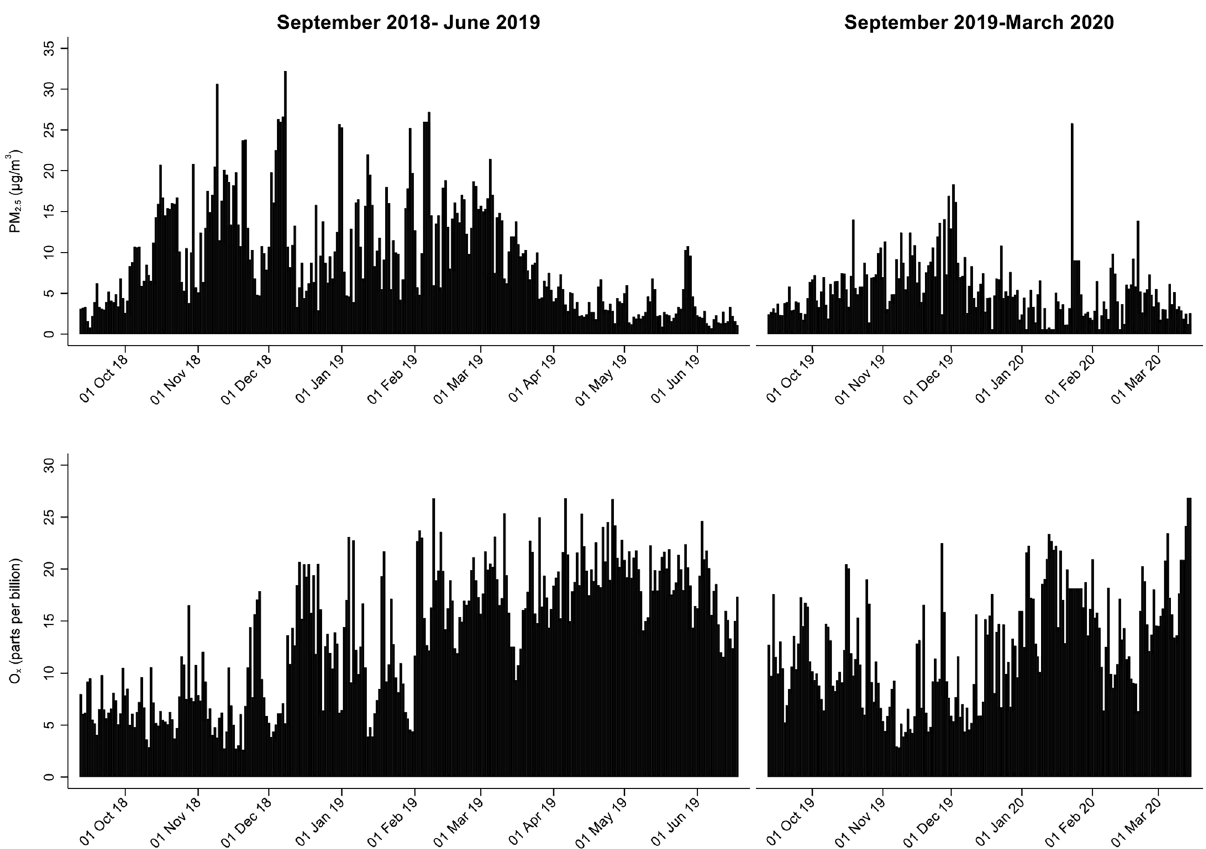
Figure 1. Distribution of daily mean ambient PM 2.5 (μg/m 3 ) and O x (parts per billion) over the study interaction between PM 2.5 and O x for CRVE (p-values from interaction terms for same-day, 3-day mean, 7-day mean, and 21-day mean exposures: 0.52, 0.63, 0.14, and 0.83, respectively). Associations between outdoor PM or O and blood pressure. Associations between outdoor 2.5 x PM 2.5 or O x concentrations and blood pressure are presented in Fig. 2 and Tables S2 and S3 of the Supplemental Material. In adjusted models, each 5 μg/m 3 increase in 3-day mean PM 2.5 was associated with a 0.95 mm Hg reduction in systolic blood pressure (95% CI − 1.86, − 0.05), 7-day mean PM 2.5 was associated with a 1.11 mm Hg reduction in systolic blood pressure (95% CI − 2.12, − 0.09), and 21-day mean PM 2.5 was associated with a was imputed (Table S4 of the Supplemental Material). Conversely, positive associations were observed between O x and systolic blood pressure, with the largest association detected for the 21-day exposure lag (estimated change per 10 ppb increase in 21-day mean O x from an adjusted model: 1.59 (95% CI − 0.06, 3.25)), but con- fidence intervals included the null for all exposure lags. There were no clear associations between PM 2.5 or O x and diastolic blood pressure. In sensitivity analyses, associations between O 3 and blood pressure were similar to those found for O x and no clear relationship was observed between NO 2 and blood pressure (Tables S5 and S6 of the Supplemental Material). When models were additionally adjusted for season, conclusions are similar except the confidence intervals for associations between 3-day and 7-day mean PM 2.5 now include the null (Table S7 and S8 of the Supplemental Material). There was evidence that 7-day mean O x modified the associations between 7-day mean PM 2.5 and systolic blood pressure (p-value from interaction term: 0.04), but there was no evidence of a significant interaction for the same-day, 3-day mean, or 21-day mean exposures (p-values from interaction terms for same-day, 3-day mean, and 21-day mean exposures: 0.63, 0.26, 0.55). Figure S3 in the Supplemental Material suggests that an inverse relationship between 7-day mean PM 2.5 and systolic blood pressure is present when 7-day mean O x con- centrations are above average (i.e., 1 standard deviation above the mean), while there is no association when O x concentrations are lower (i.e., 1 standard deviation below mean). O x did not modify associations between PM 2.5 or diastolic blood pressure for any exposure lags (p-value for interaction term for same-day, 3-day mean, 7-day mean, and 21-day mean exposures: 0.57, 0.46, 0.51 and 0.61).